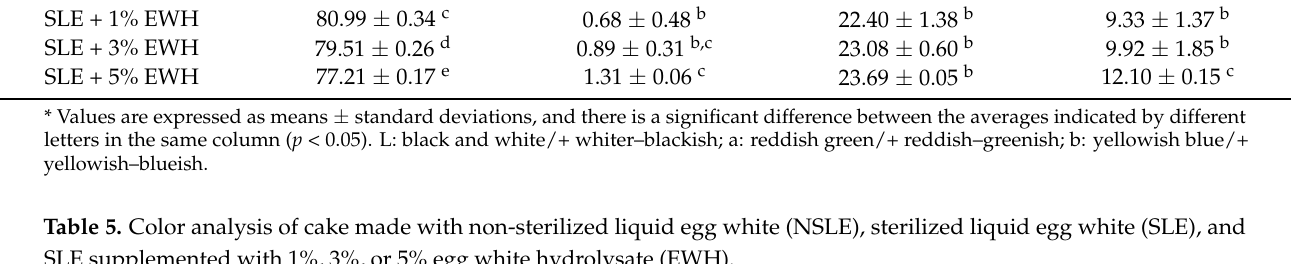
Table 5. Color analysis of cake made with non-sterilized liquid egg white (NSLE), sterilized liquid egg white (SLE), and SLE supplemented with 1%, 3%, or 5% egg white hydrolysate (EWH).